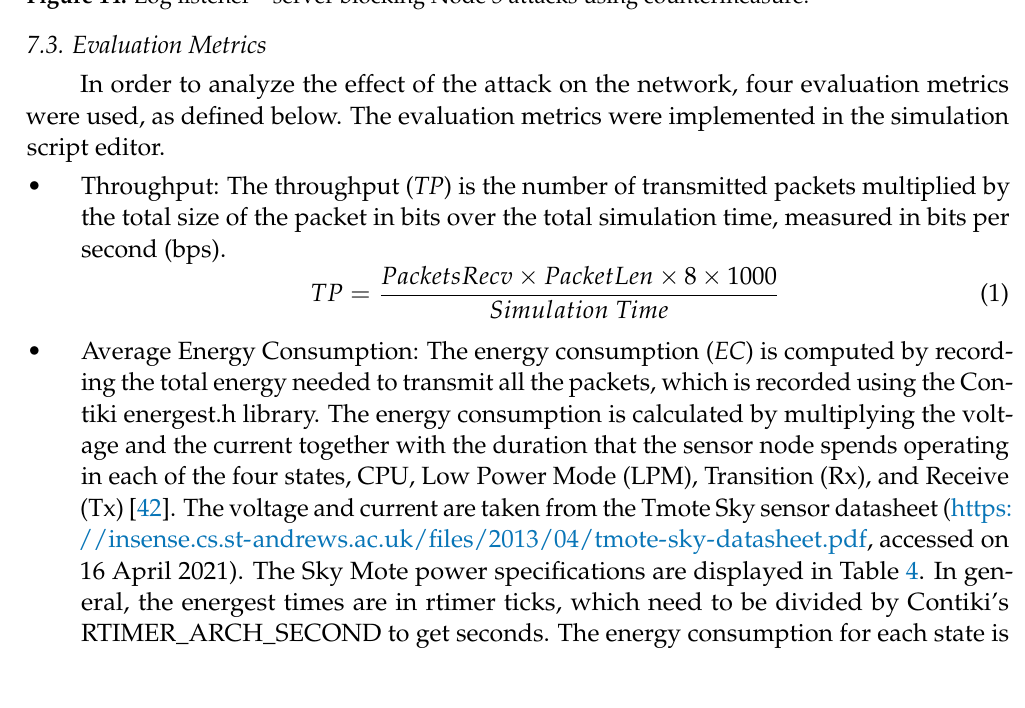
Figure 14. Log listener—server blocking Node 3 attacks using